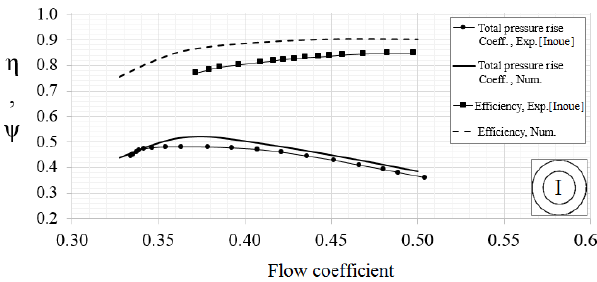
Figure 6. Comparison between present numerical performance maps with experimental results of Inoue and Kuroumaru (1989).